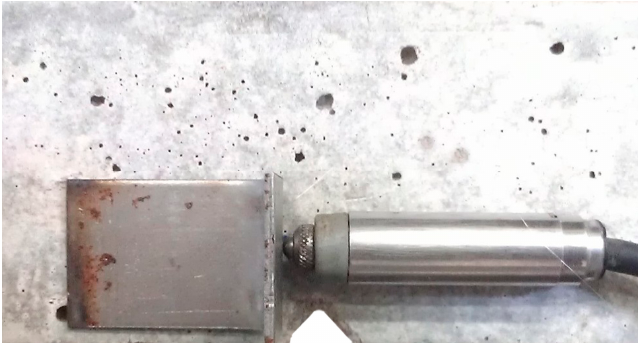
Figure 3. LVDT positioned at the side face of a specimen to measure the crack size at the height of the embedded capsule.